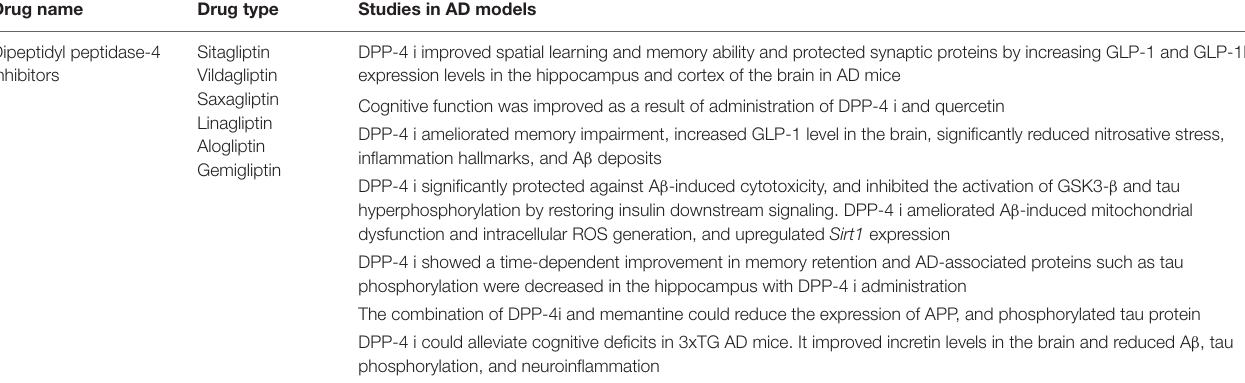
TABLE 1 | Research of DPP-4 inhibitors in AD models. Drug name Drug type Studies in AD models Dipeptidyl peptidase-4 Inhibitors